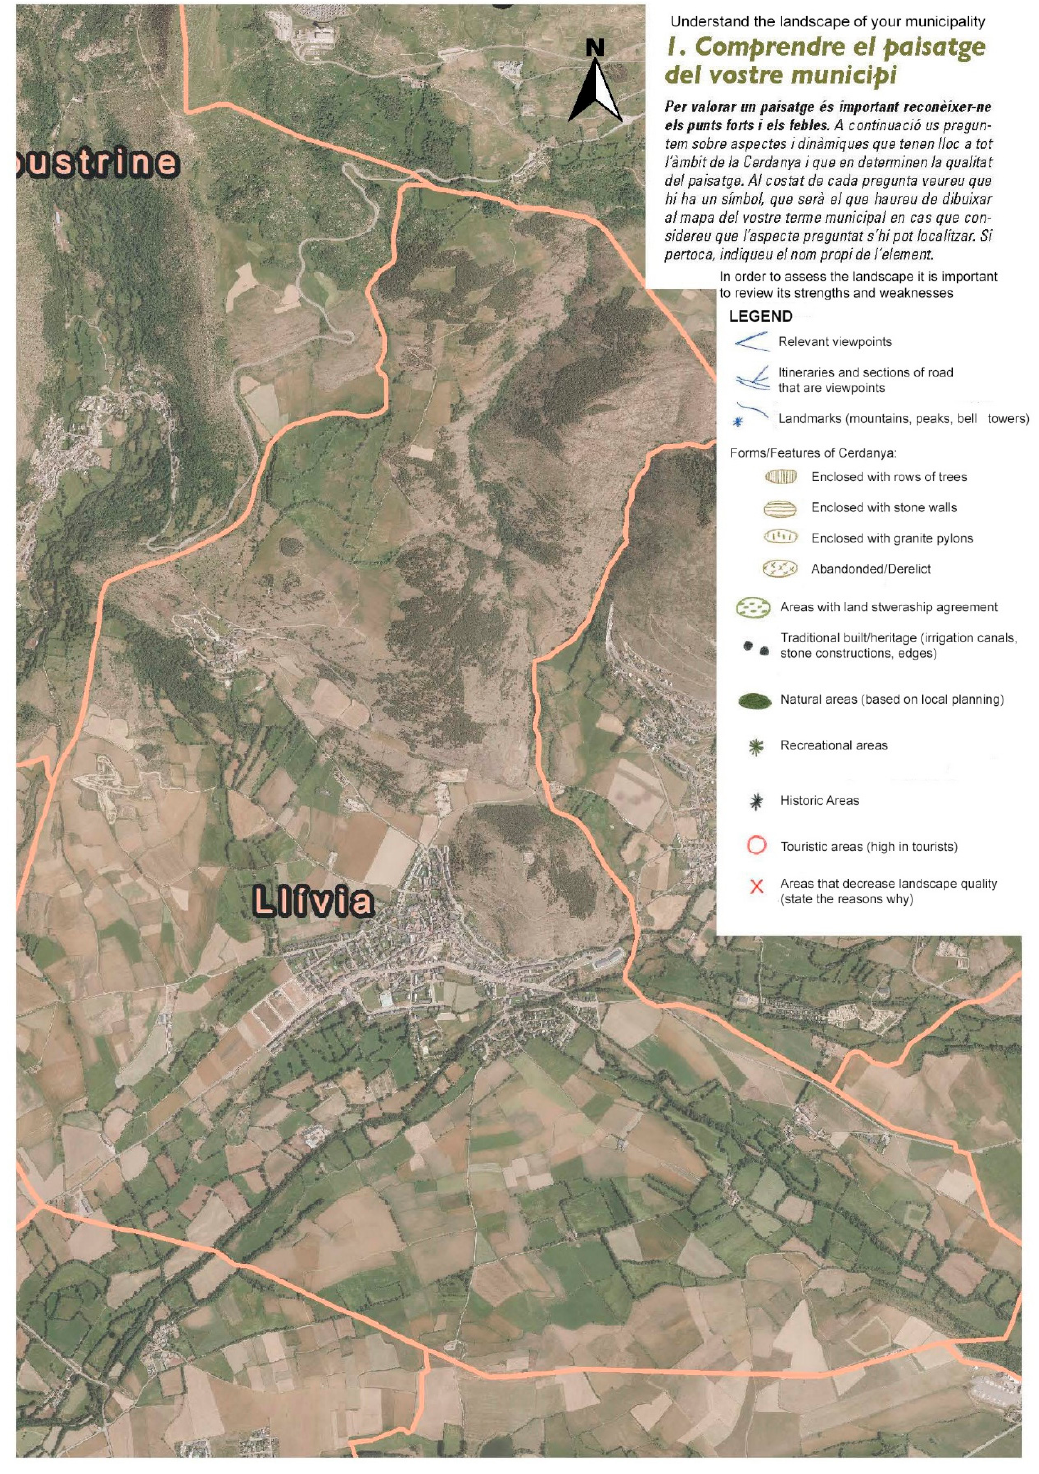
Figure 4. Map of Llivia, La Cerdanya. Landscape Observatory. Example of an activity designed for a participation process method in La Cerdanya, where attendees were asked to identify key characteristics of their area. Image courtesy of Irene Navarro; original canvas produced in Catalan (English translation of the legend by authors for the purposes of this paper).